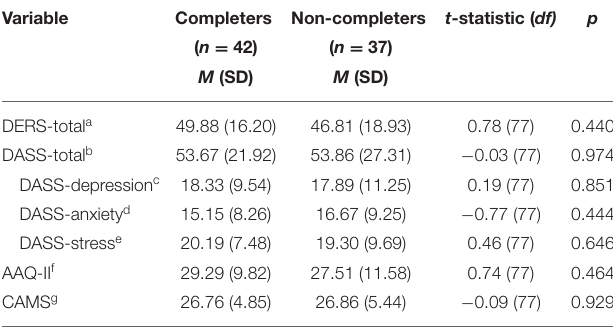
TABLE 4 | Comparison of completers and non-completers across baseline measures of mental health and emotion regulation.